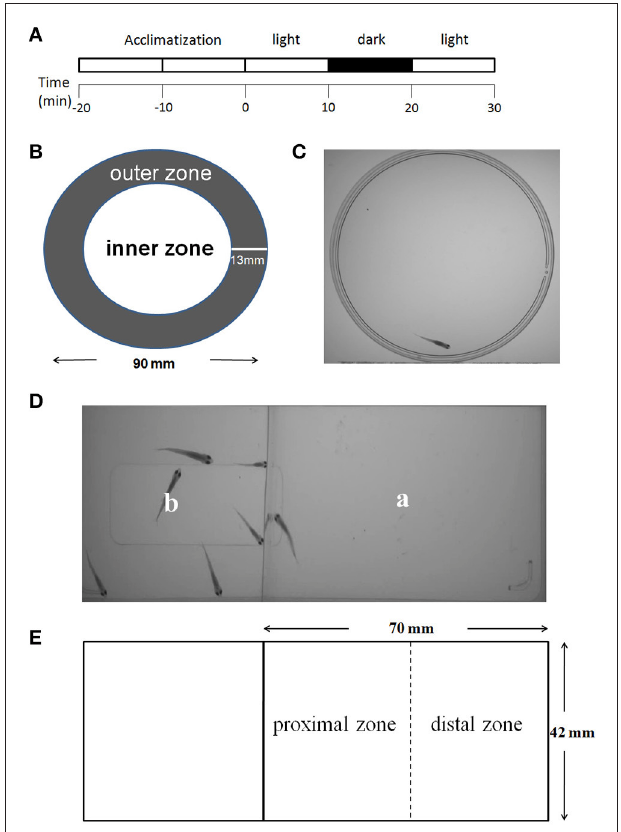
FIGURE 2 | Behavioral testing procedures. The procedures for the behavioral tests of locomotor activity, thigmotaxis, and behavioral response to light change consisted of four steps: a 20min acclimatization phase, the first light phase (minutes 0–10), a dark phase (minutes 10–20), and the second light phase (minutes 20–30) (A) . The tests of the above behaviors were performed in a dish (diameter of 90mm). The inner and outer zones were delineated as shown above. The width of the outer zone was set at 13mm to the border of the dish (B,C) . The social preference was tested in a rectangular chamber. The fish being tested was placed in area “a,” and six companion zebrafish were placed in area “b” (D) . “a” was the test area (70 × 42mm) and was equally divided into one proximal zone and one distal zone (E)